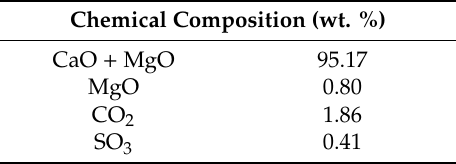
Table 2. Chemical composition of hydrated